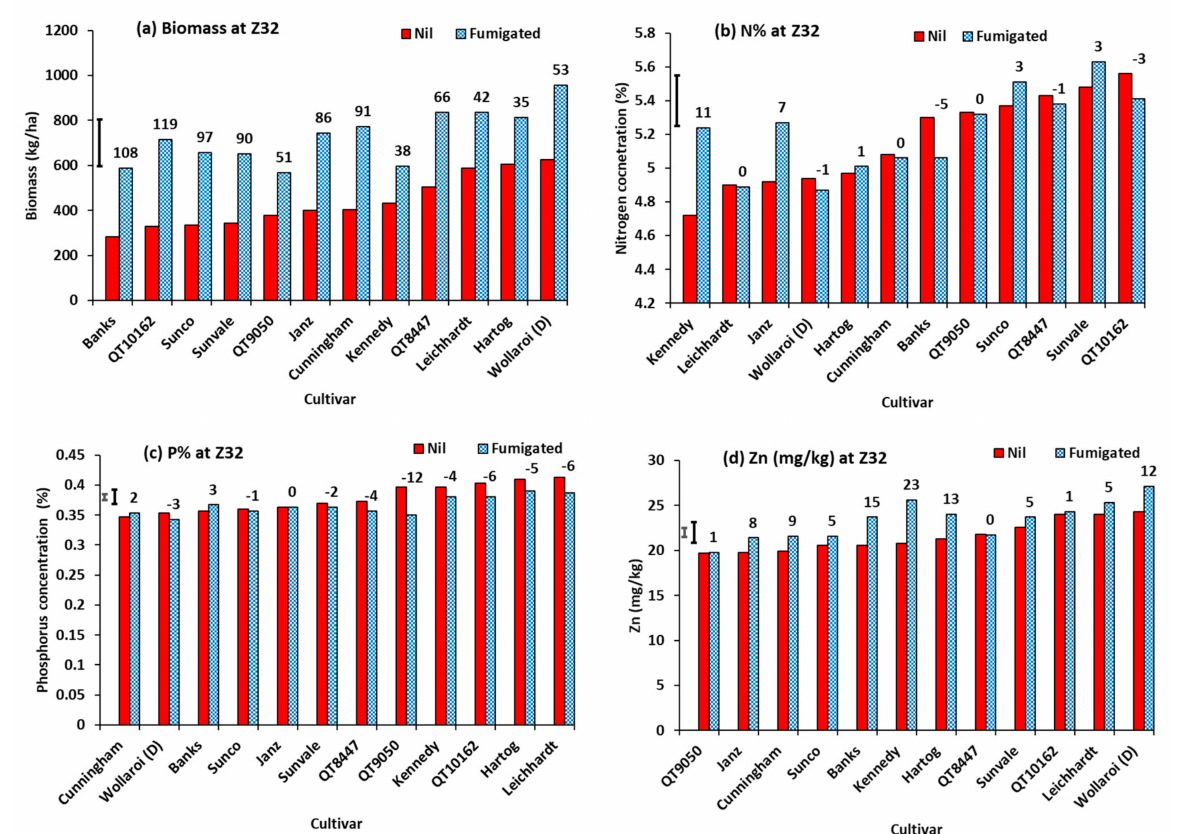
Figure 7. Response of wheat and durum cultivars at stem elongation (Z32) to soil fumigation with methyl bromide in Experiment 3, ( a ) plant biomass, ( b ) N concentration, ( c ) P concentration and ( d ) Zn concentration. Bar markers represent the l.s.d. for ( a ) fumigation x cultivar interaction, ( b ) cultivar main effect and ( c , d ) main effects of fumigation and cultivar. (D) signifies a durum cultivar. Each graph is presented with nil-treated cultivars in ascending order of Y -axis value. Values above bars are the percentage response to fumigation.